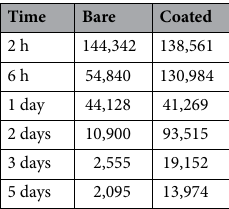
Table 2. Concentrations of black pigment as pixel values obtained from histopathological images of Figs. 8 and 9, using the ImageJ software. Note that 1 pixel is equal to ~ 1.92